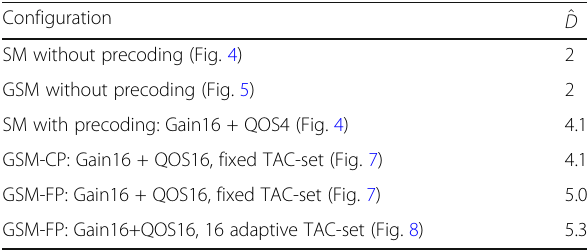
Table 4 Diversity order comparison for N r = 2 and QPSK. For GSM, N t = 5, N a = 2. For SM, N t = 8, N a =